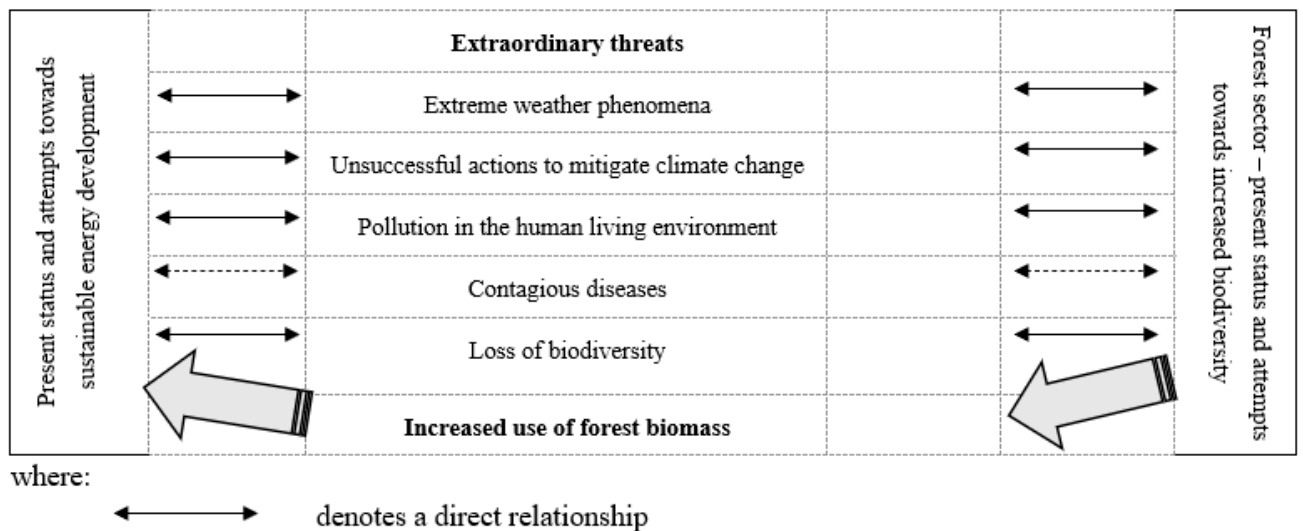
Figure 5. Cause-and-effect relationships between assumptions of the concept of resilience and sustainable energy development using forest biomass. Source: the authors’ study.